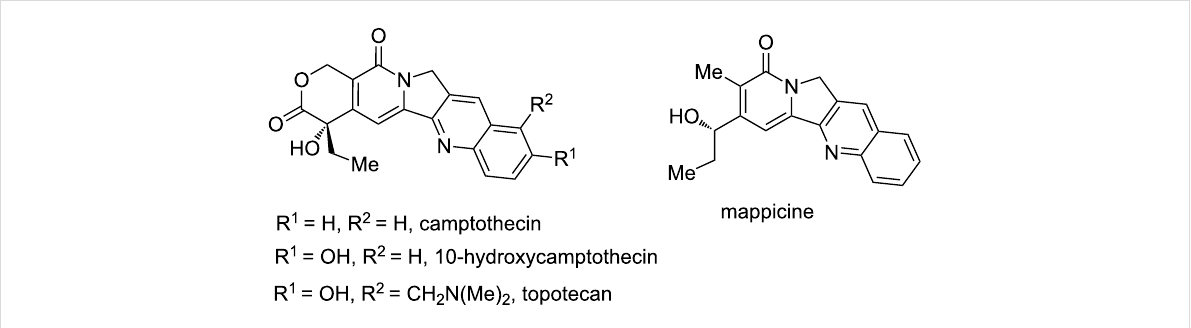
Figure 1: Selected examples of natural products with a tricyclic indolizinone scaffold.